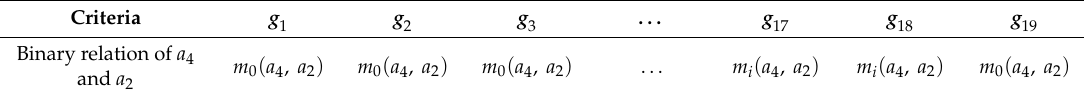
Table 13. Binary outranking relations when comparing configurations E(5) and C(3).